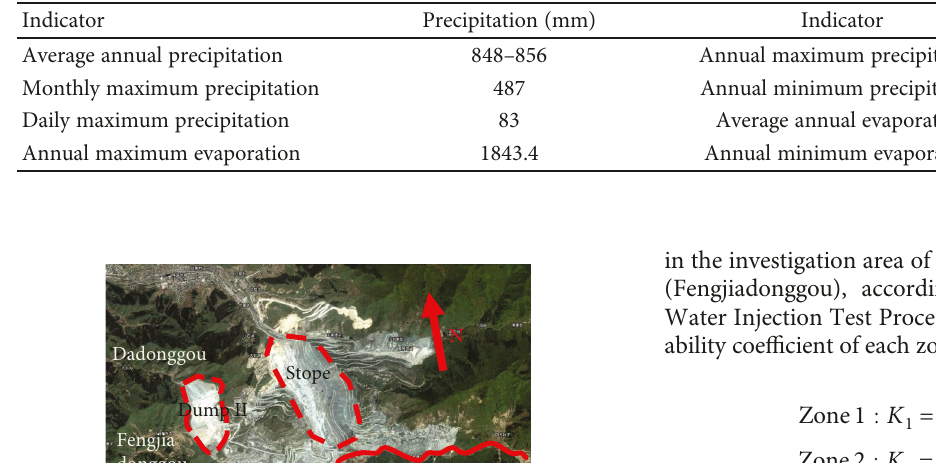
Table 3: Statistics of precipitation in the Benxi area.